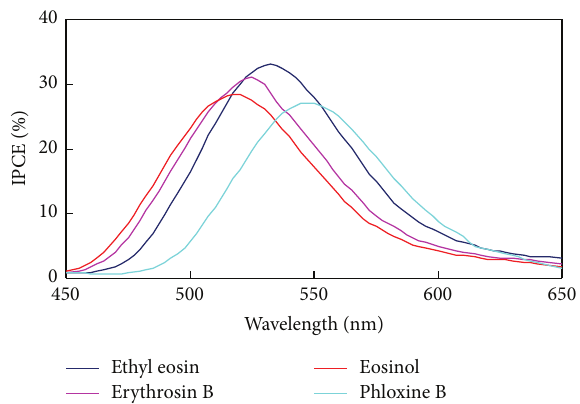
Figure 7: Photocurrent action spectra obtained with the use of triarylmethane based dyes as